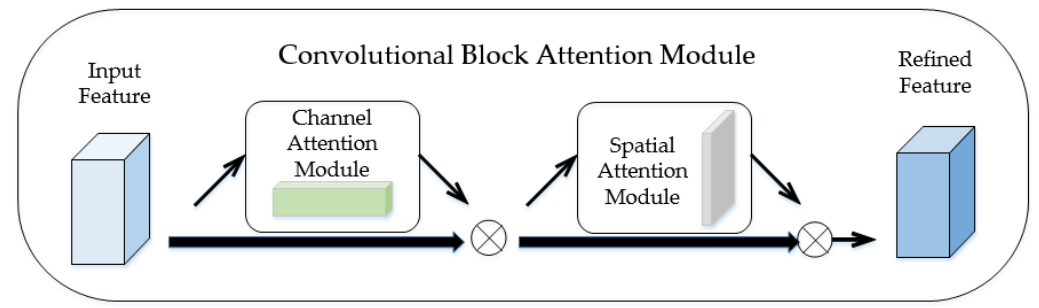
Figure 1. Convolutional block attention module (CBAM) structure.